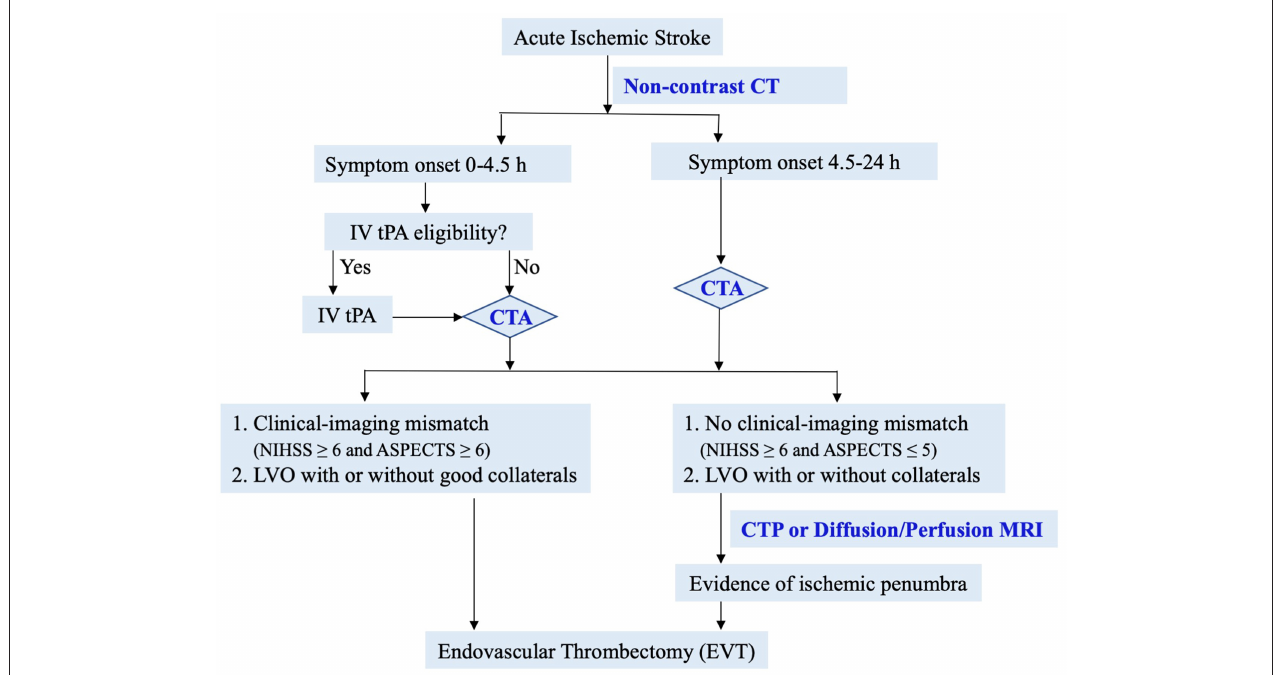
FIGURE 3 | Proposed simple imaging guide for endovascular thrombectomy.